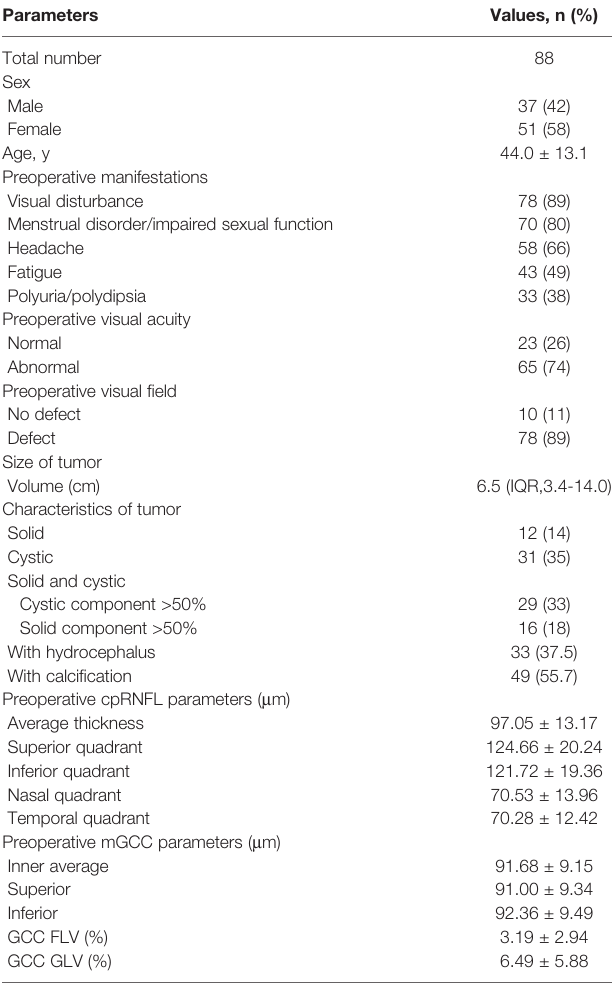
TABLE 1 | Clinicoradiological characteristics of the 88 enrolled